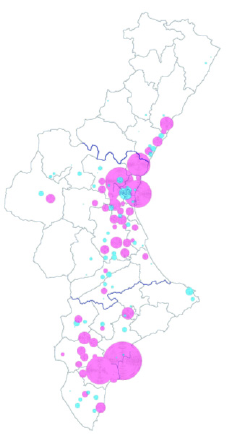
Figure 4. Social dwellings’ location.